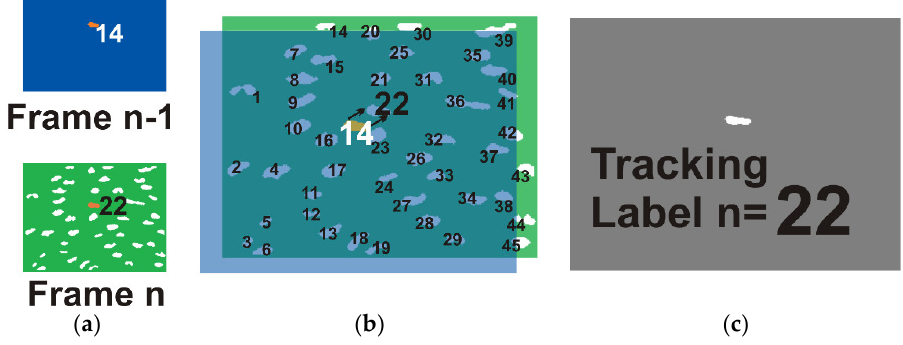
Figure 7. The intersection process to track cells, from frame n-1 to frame n, is illustrated. ( a ) The kernel of a selected cell with track_label = 14 in frame n − 1 (blue background and orange highlighted) and the binarized and labeled frame n are the input data, notice that the corresponding label for selected cell will be 22; ( b ) Kernel and binary image are overlapped to show the intersection process, which is a logical and operation between them; ( c ) The outcome is a new kernel, in this case only one object was generated by the intersection; based on its position in frame n the new track_label value is updated to 22. This iterative process is performed per each selected cell (ROI) and each frame.